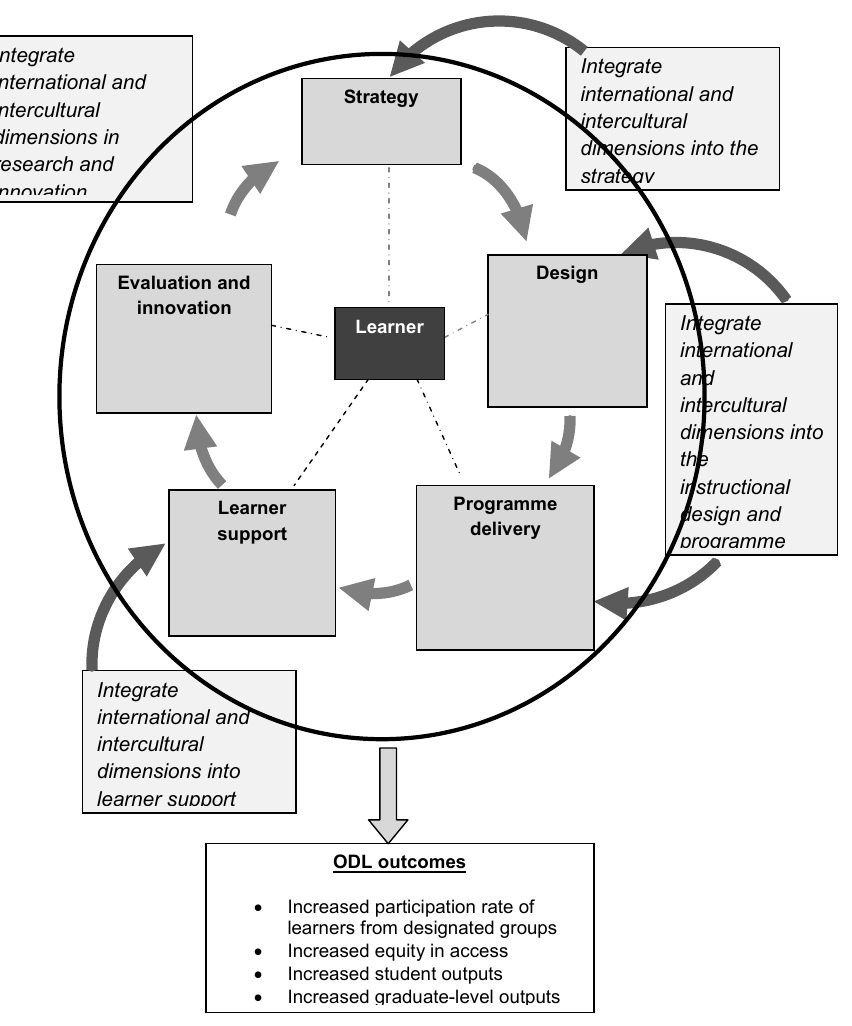
Figure 4 . Illustrating the interplay between ODL and